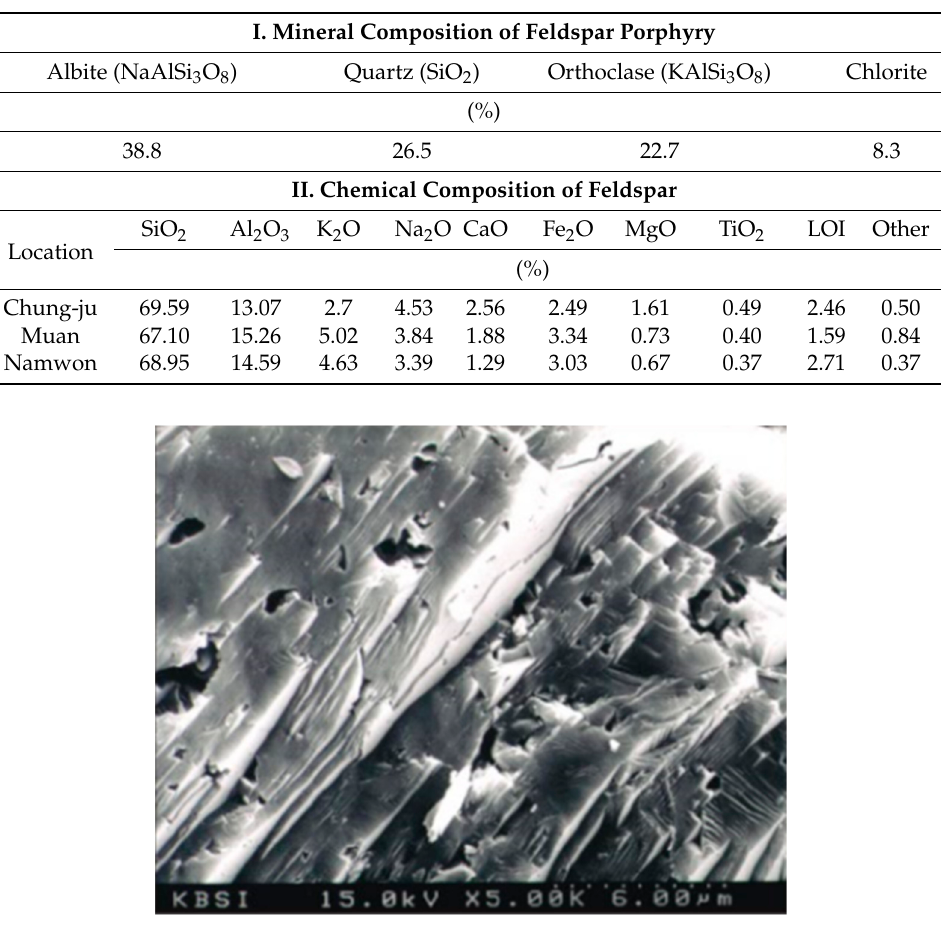
Figure 2. SEM image of weathered feldspar